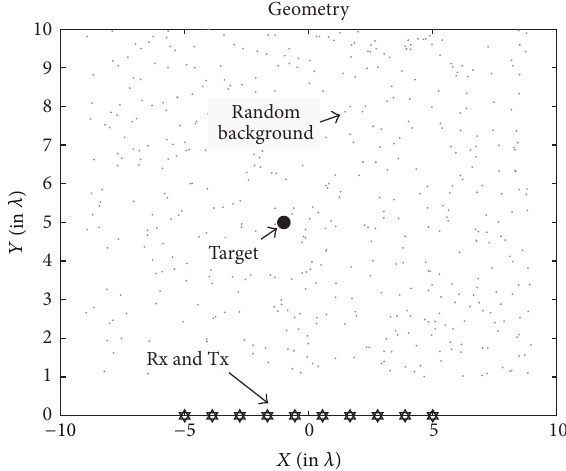
Figure 6: Geometry of the experiment, based on a collection of randomly positioned point scatterers forming the medium. The target is a point scatterer located inside this